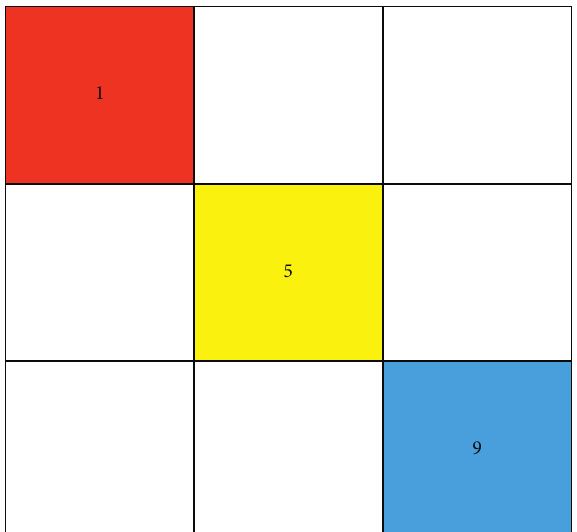
Figure 13: Schematic diagram of selecting partition area.